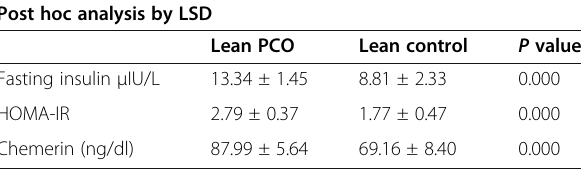
Table 7 Post hoc analysis (lean PCO and lean control) as regards fasting insulin, HOMA-IR, and chemerin